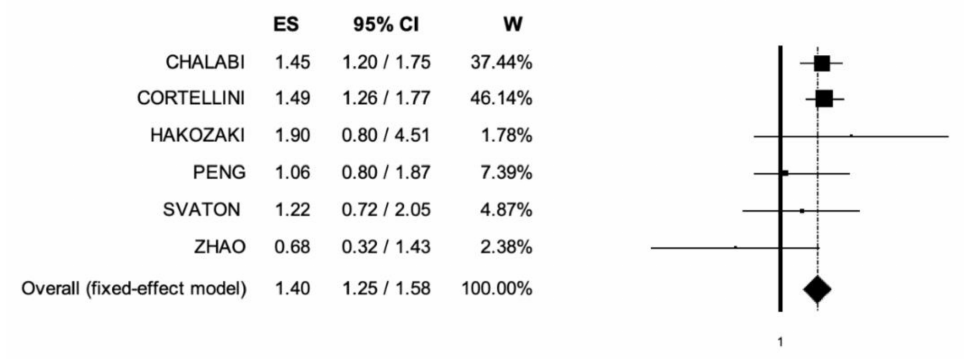
Figure 2. Forest plot of comparison between non-small cell lung cancer patients receiving immune checkpoint inhibitors with concomitant PPIs and/or H2RAs use or not; the outcome (ES) was Hazard Ratio of Overall Survival. Abbreviations: CI: confidence interval; ES: Effect Size (Hazard Ratio); W: Weight.